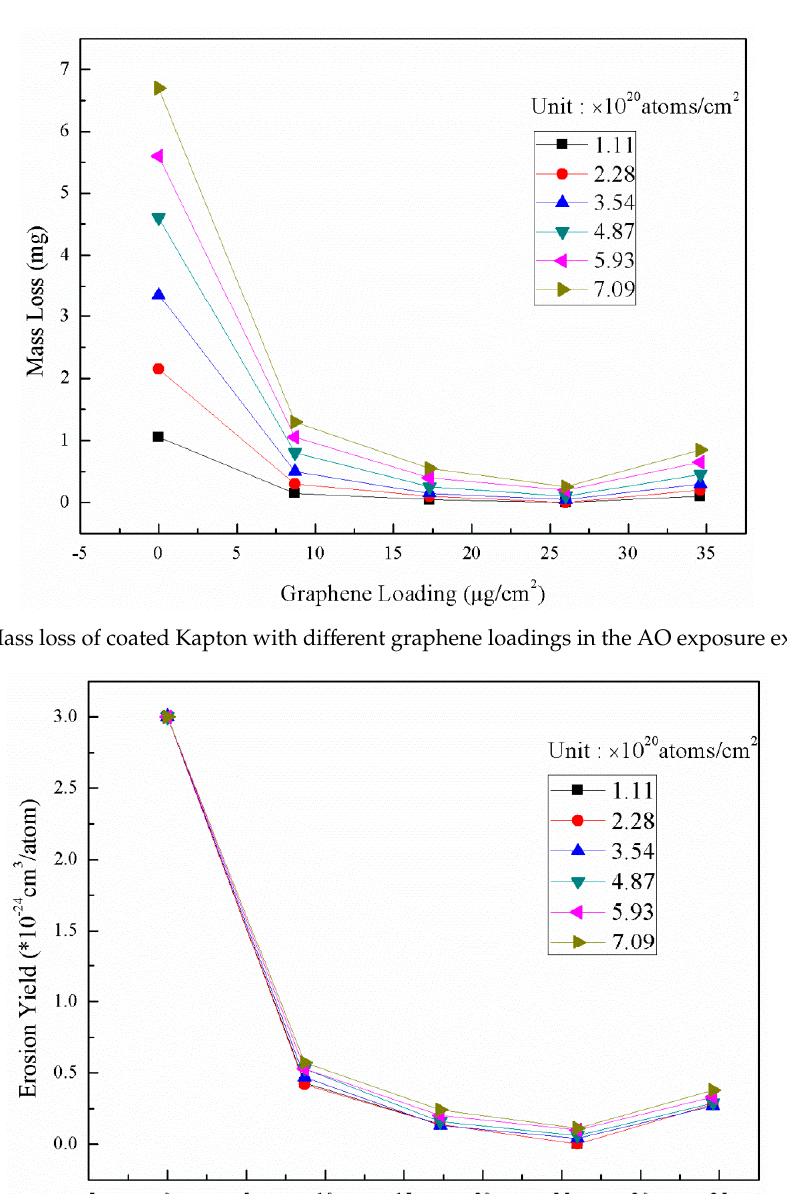
Figure 8. Erosion yield of coated Kapton with different graphene loadings in the AO exposure